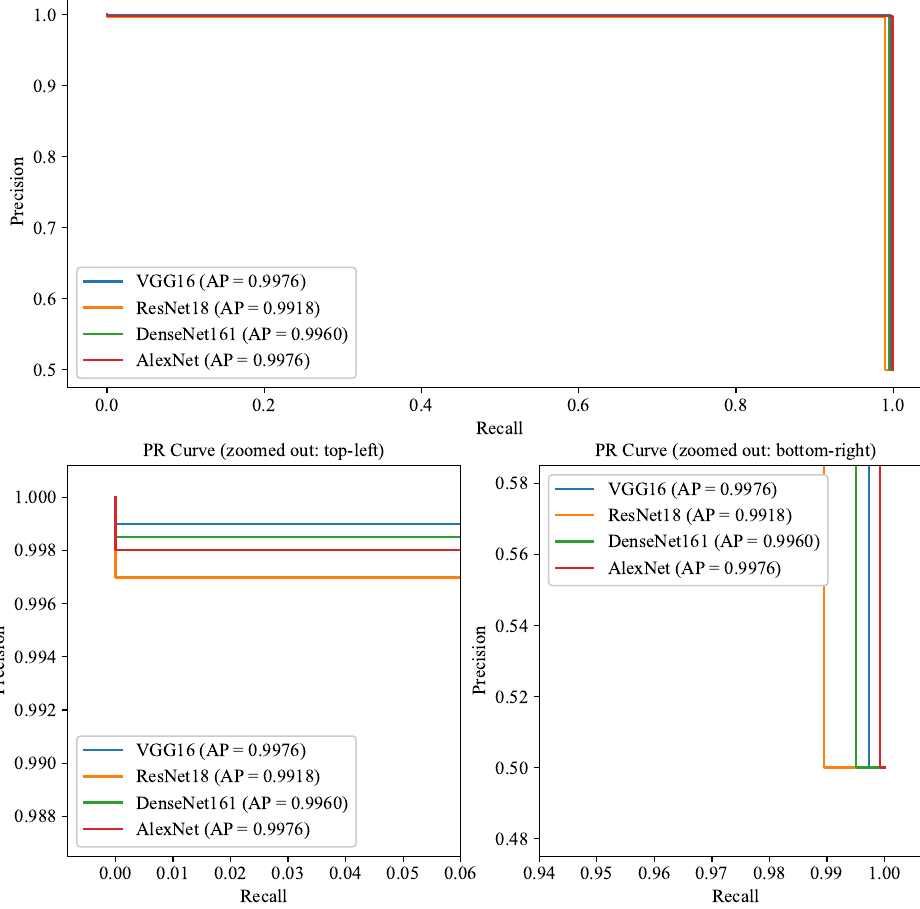
Figure 14. PR curve of different TL